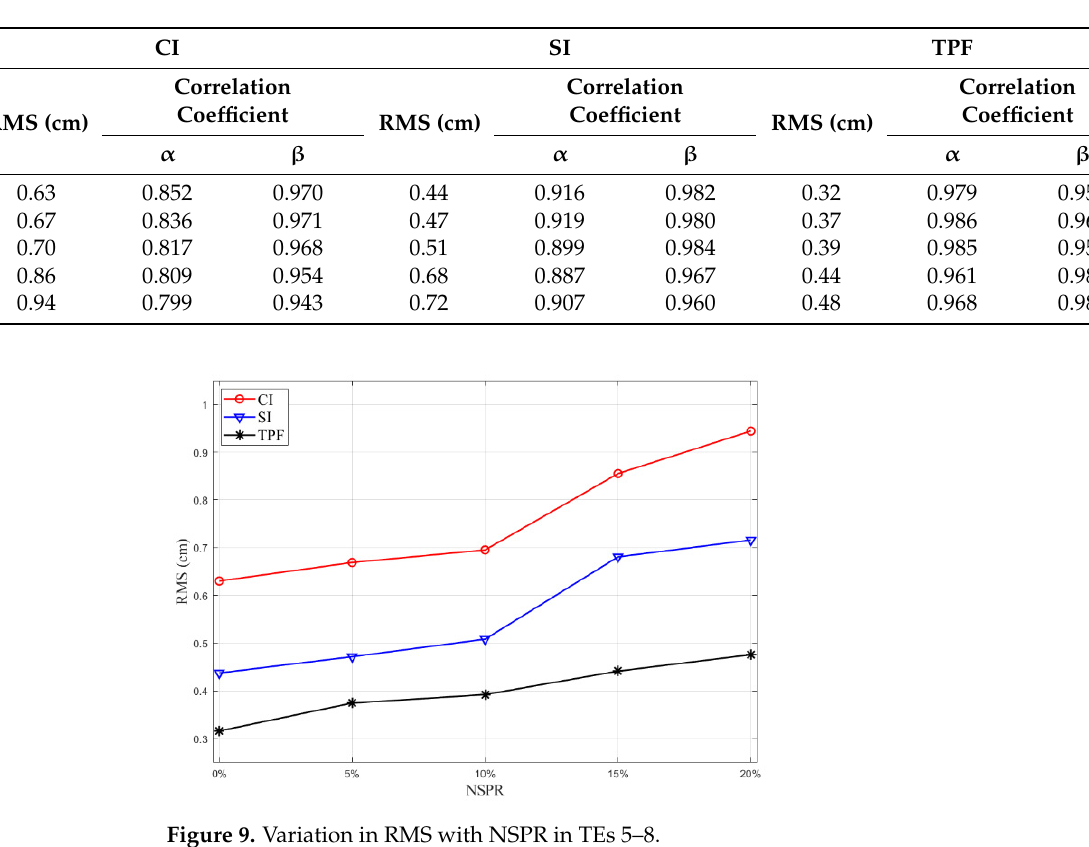
Table 2. RMS errors and correlation coefficients of TE 5–8.